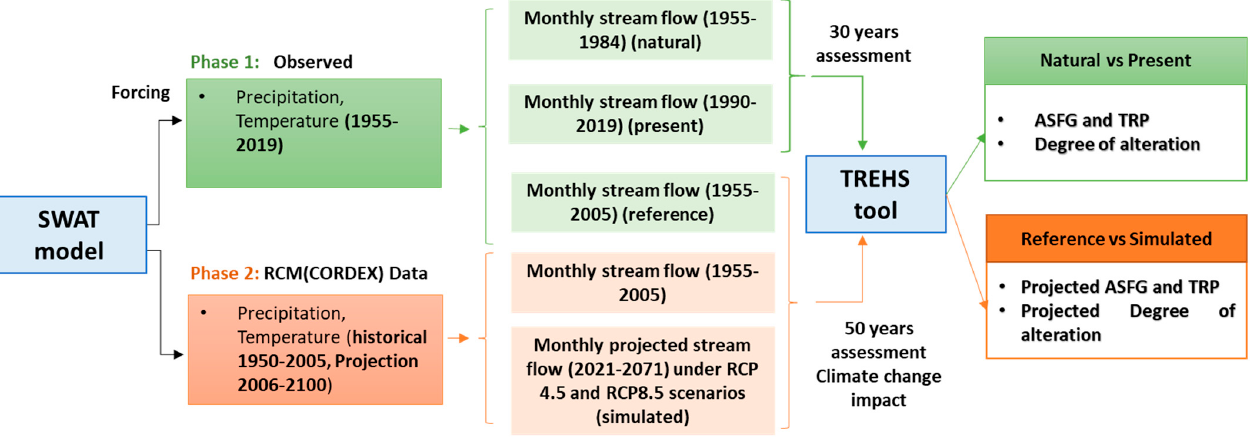
Table 3. Parameters used in the calibration process .